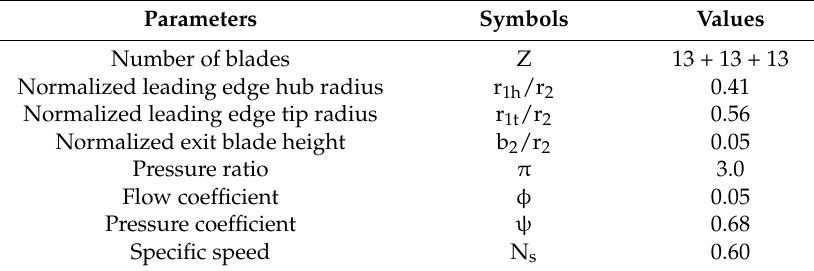
Figure 1. Datum impeller. Table 1. Main specifications of datum impeller.